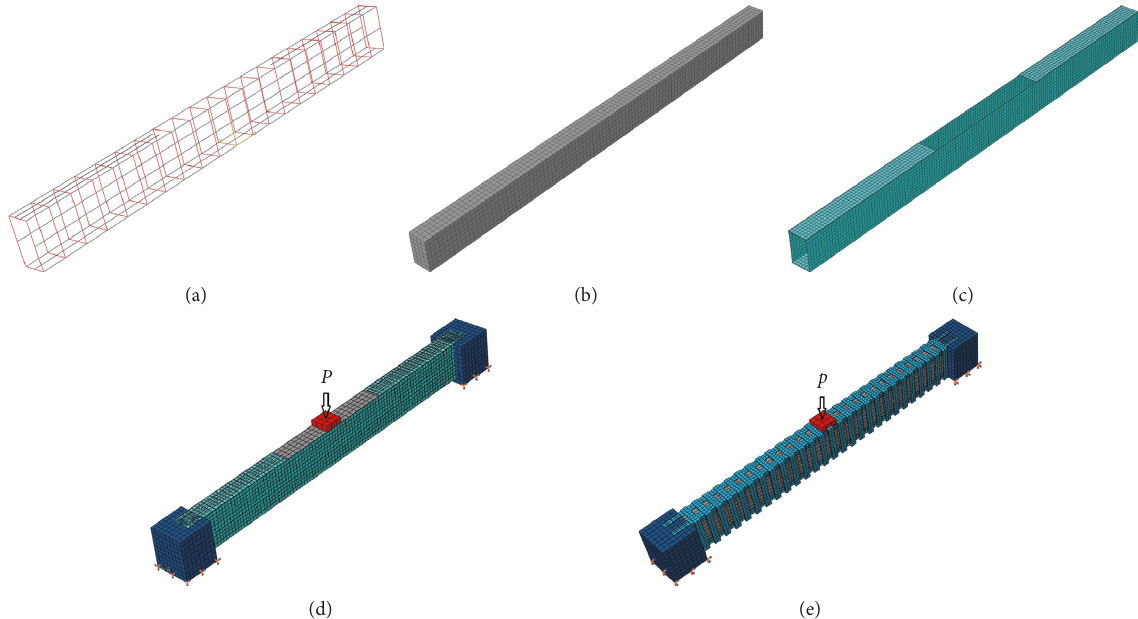
Figure 9: Finite element model of (a) reinforcement skeleton, (b) concrete, (c) steel plate for strengthening, (d) reinforced frame beam, and (e) reinforced RC beam for contrast.